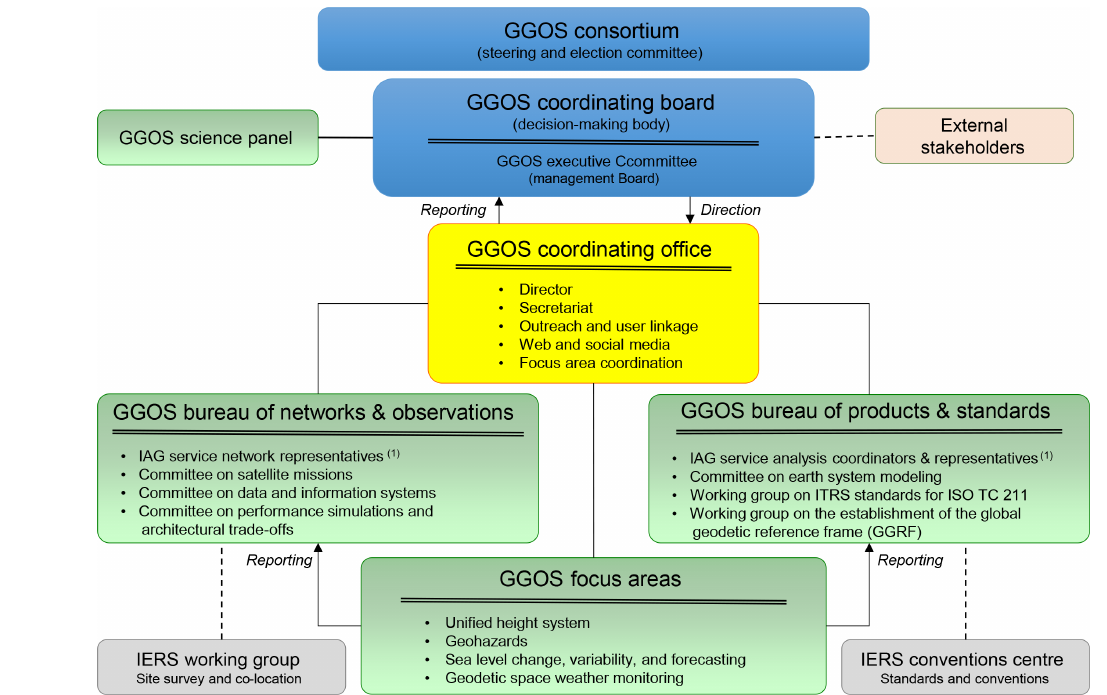
Figure 9. Structure of IAG’s Global Geodetic Observing System